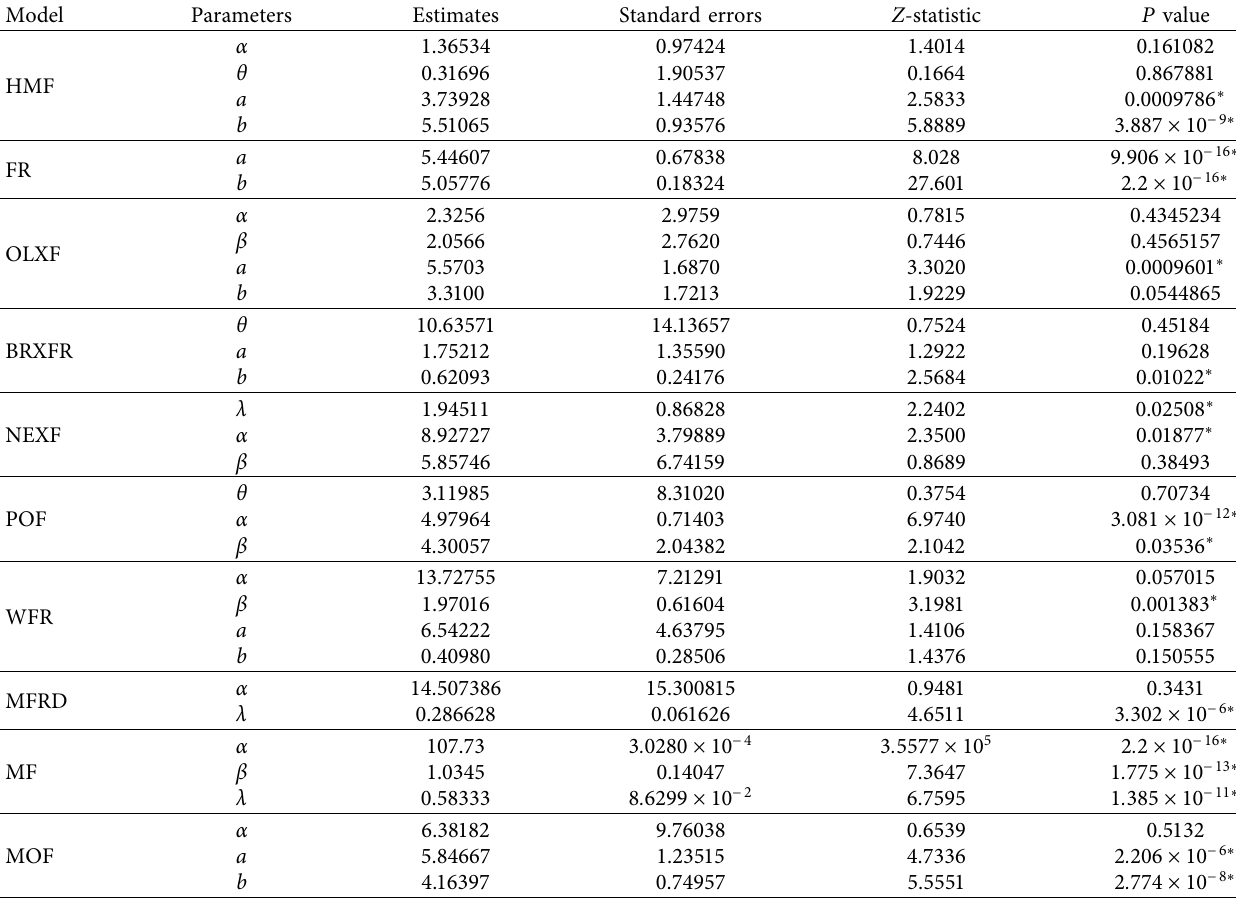
Table 10: MLEs for Ghana unemployment rate dataset.